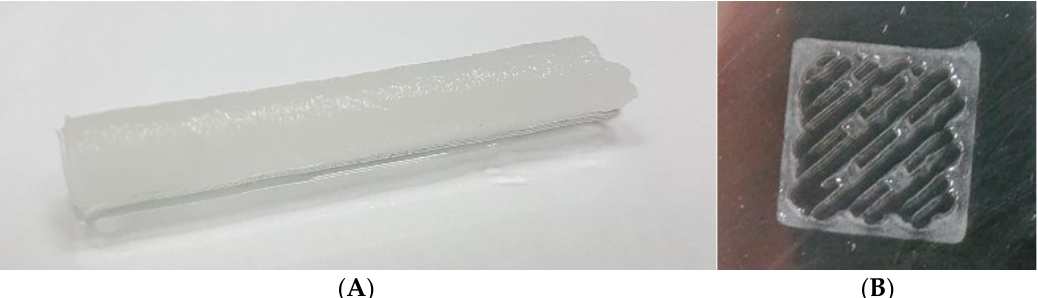
Figure 9. Materials obtained based on the PLA-MA/NCC-MA/Gel-MA mixture by: ( A ) cryogelation in 1 mL syringe; ( B ) 3D printing. The 80:20 weight ratio of PLA-MA and NCC-MA along with 20 wt% GelMA was applied for the preparation of these materials.